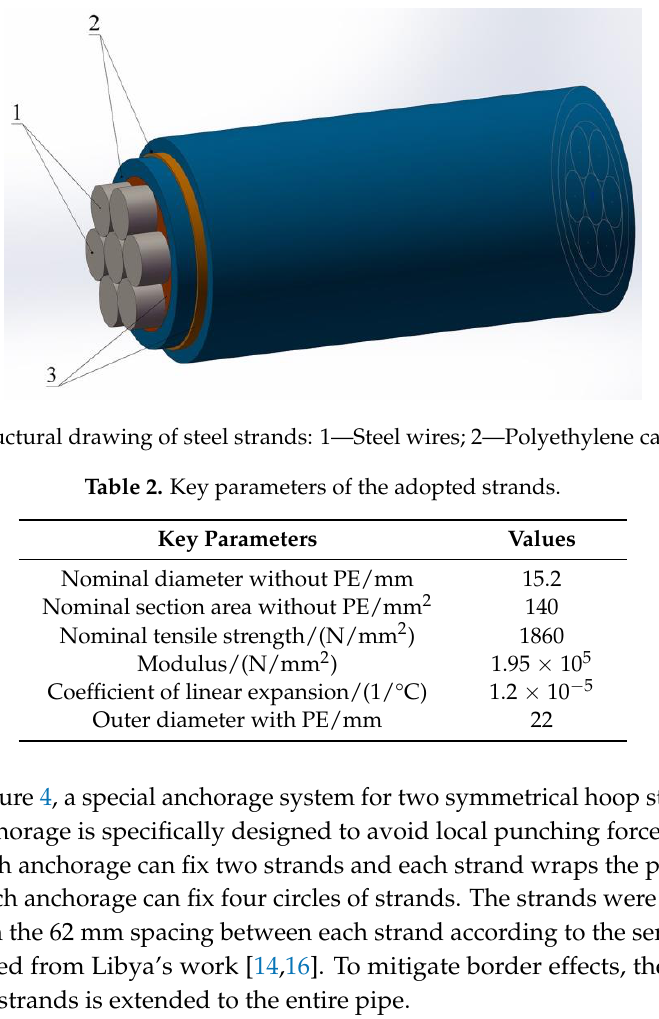
Figure 4. The system of each anchorage.